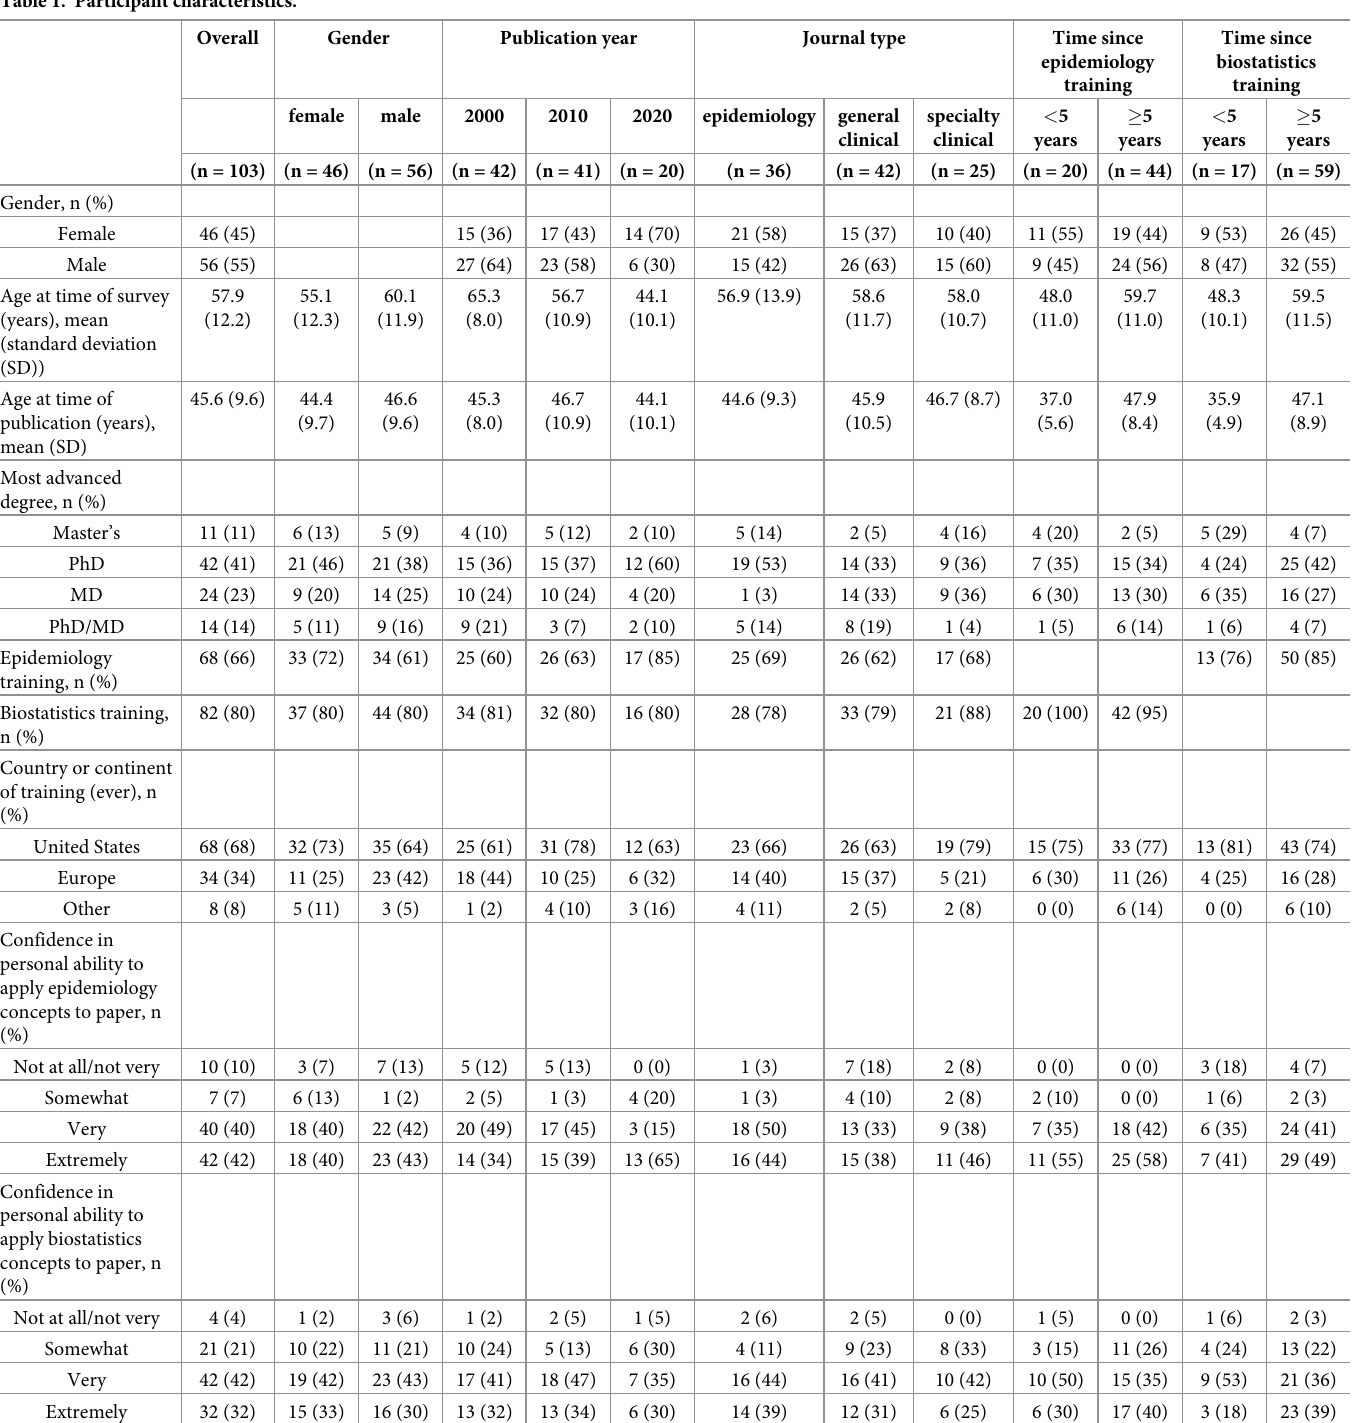
Table 1. Participant